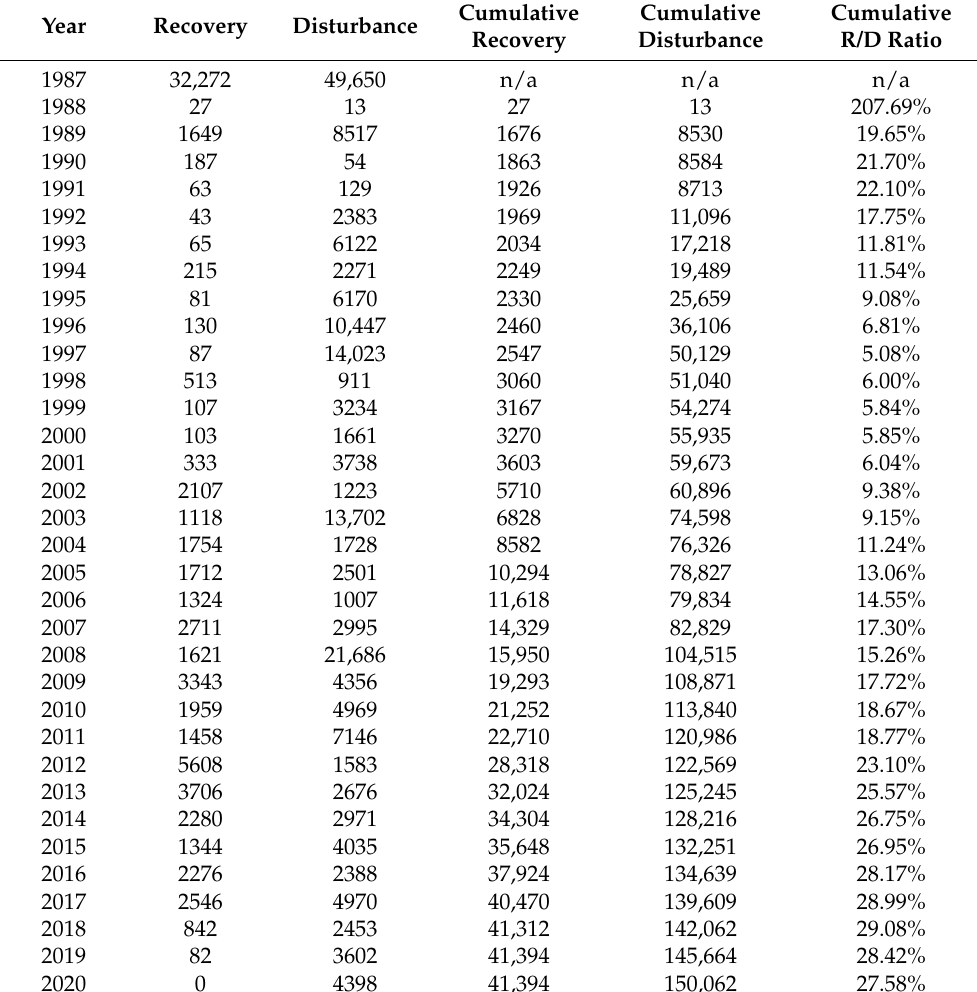
Table A2. The number of yearly and cumulative disturbed and recovery pixels from 1987 to 2020 in the eastern